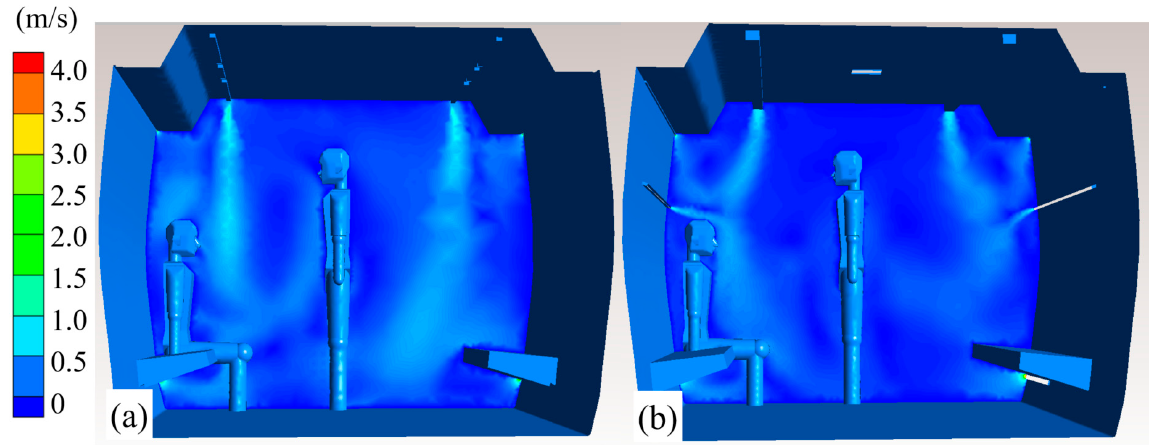
Figure 4. Velocity field contours of cars equipped with ( a ) CV and ( b ) SV.